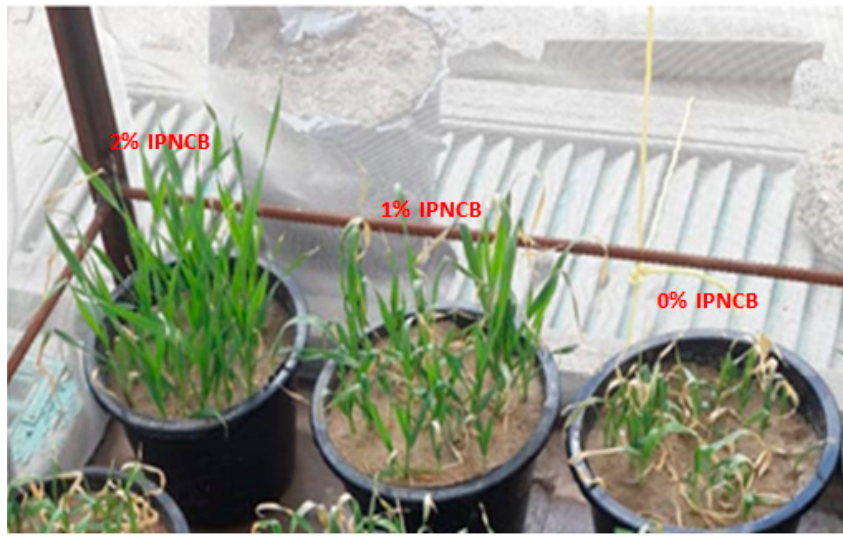
Figure 12. Effect of the IPNCB composite on wheat plant growth.